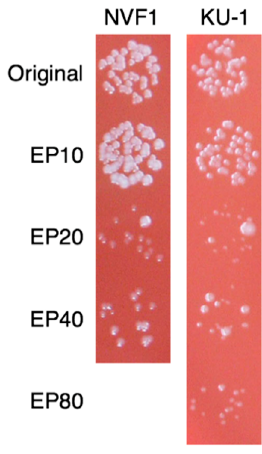
Figure 4. Colony morphology of passaged variants. Five µL of suspended bacteria of original and NVF1 and KU-1 variants passaged on Eugon chocolate agar 10, 20, 40, and 80 times (EP10, EP20, EP40, and EP80 (for KU-1), respectively) were cultured on chocolate agar (II) (BD) for 3 days. Note that original and EP10 form small white convex colonies whereas variants passaged more than 20 times formed tiny flat translucent colonies.